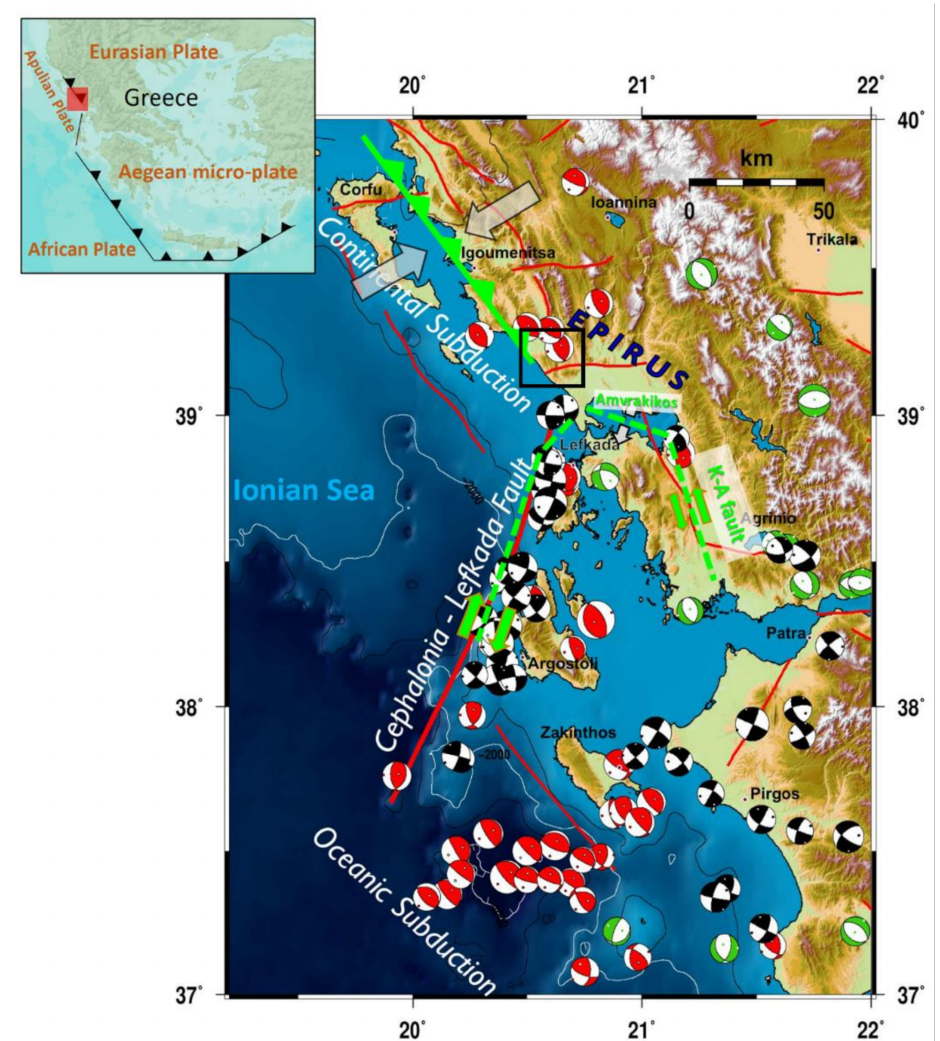
Figure 1. Simplified tectonic regime near the location of the 2020 Kanallaki sequence (black rectangle) showing the triple junction of western Greece (light green notations). K–A fault notation is the Katouna–Amfilochia fault. The green dashed-line sketch of the Cephalonia–Lefkada fault Zone is based on [16]. Focal mechanisms (beachballs) indicate the representative kinematics at each area. Faults are from the GreDaSS fault database [17]. The inset shows the study area in a broader tectonic